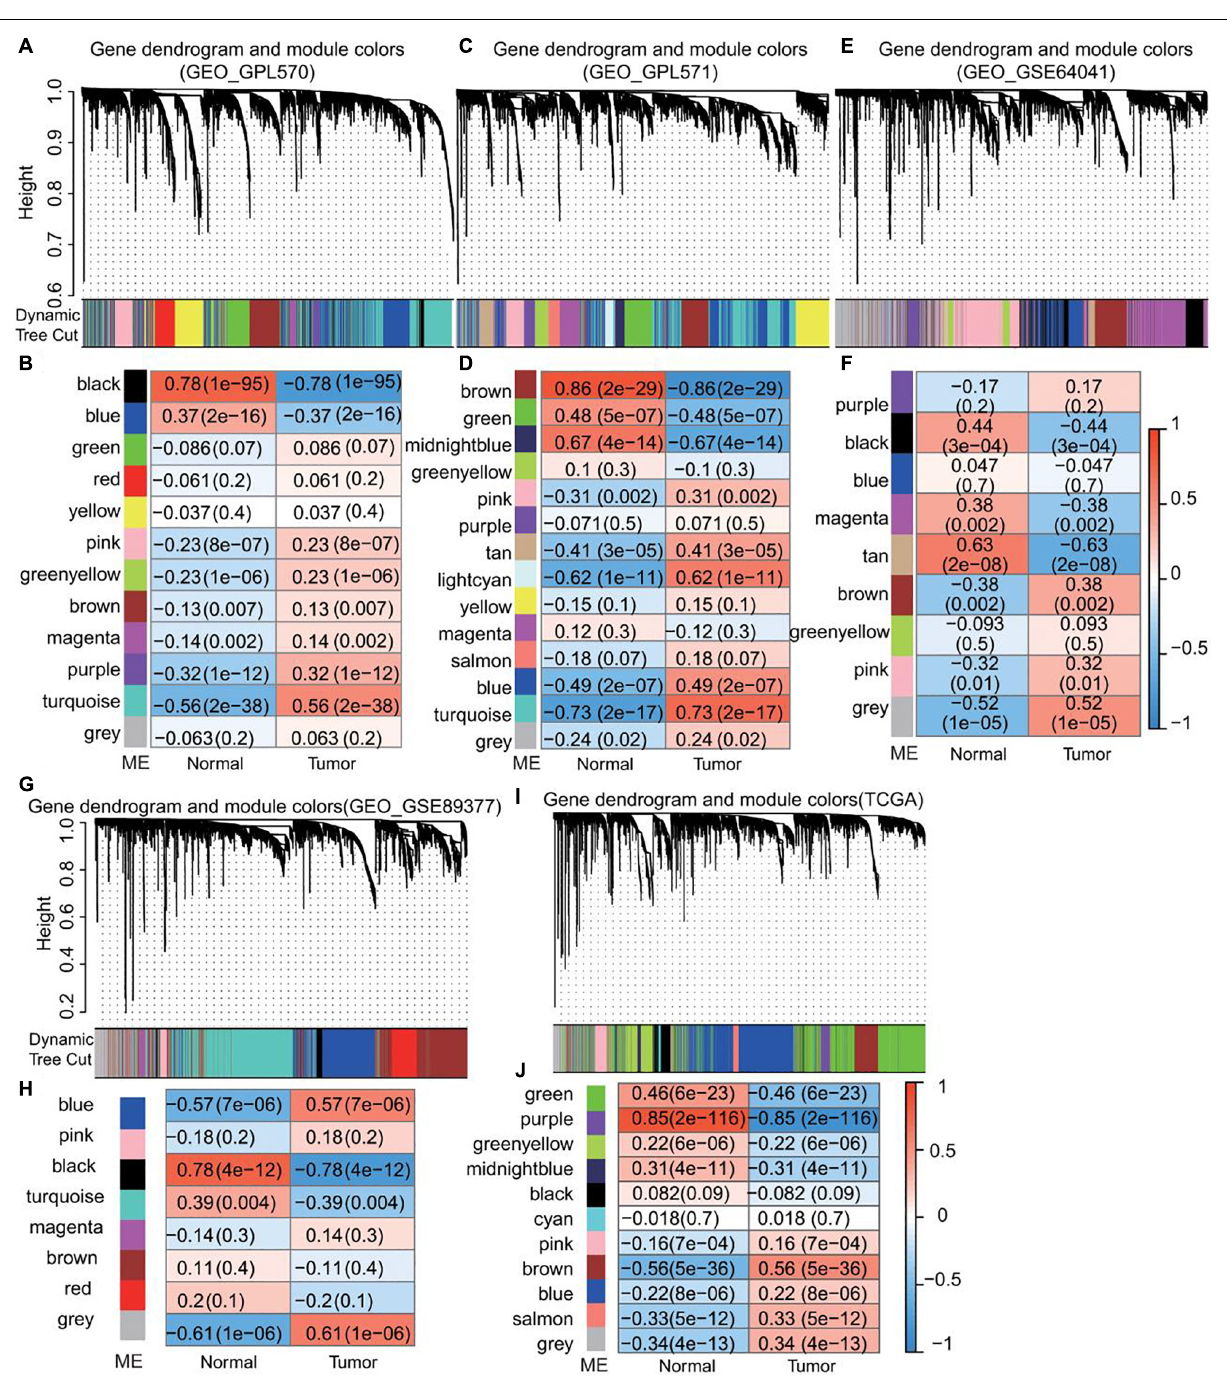
(MCC), Maximum Neighborhood Component (MNC), and centralities based on shortest paths, such as Bottleneck (BN), Closeness, EcCentricity (EC), Radiality, Betweenness, Stress, and Clustering Coefficient (CC) were intersected. Finally, 14 hub